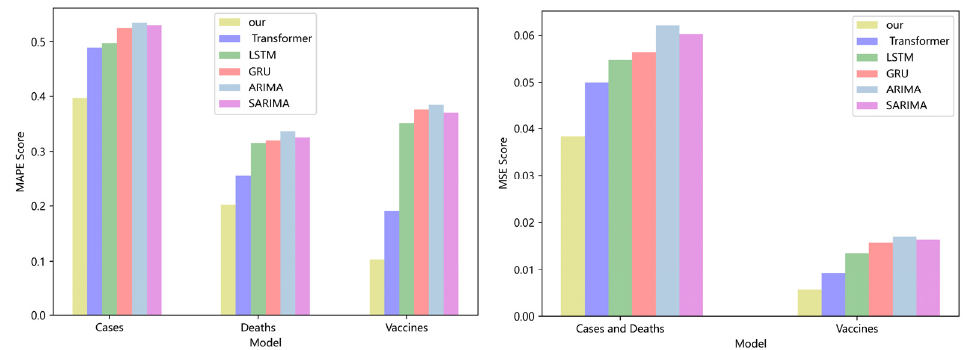
Figure 3. Comparison of MAPE and MSE score for CA cases, deaths, and vaccines.